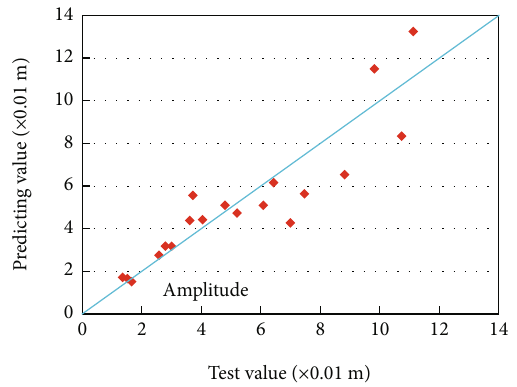
Figure 6: Predicted and experimental values of the fi rst wave amplitude.